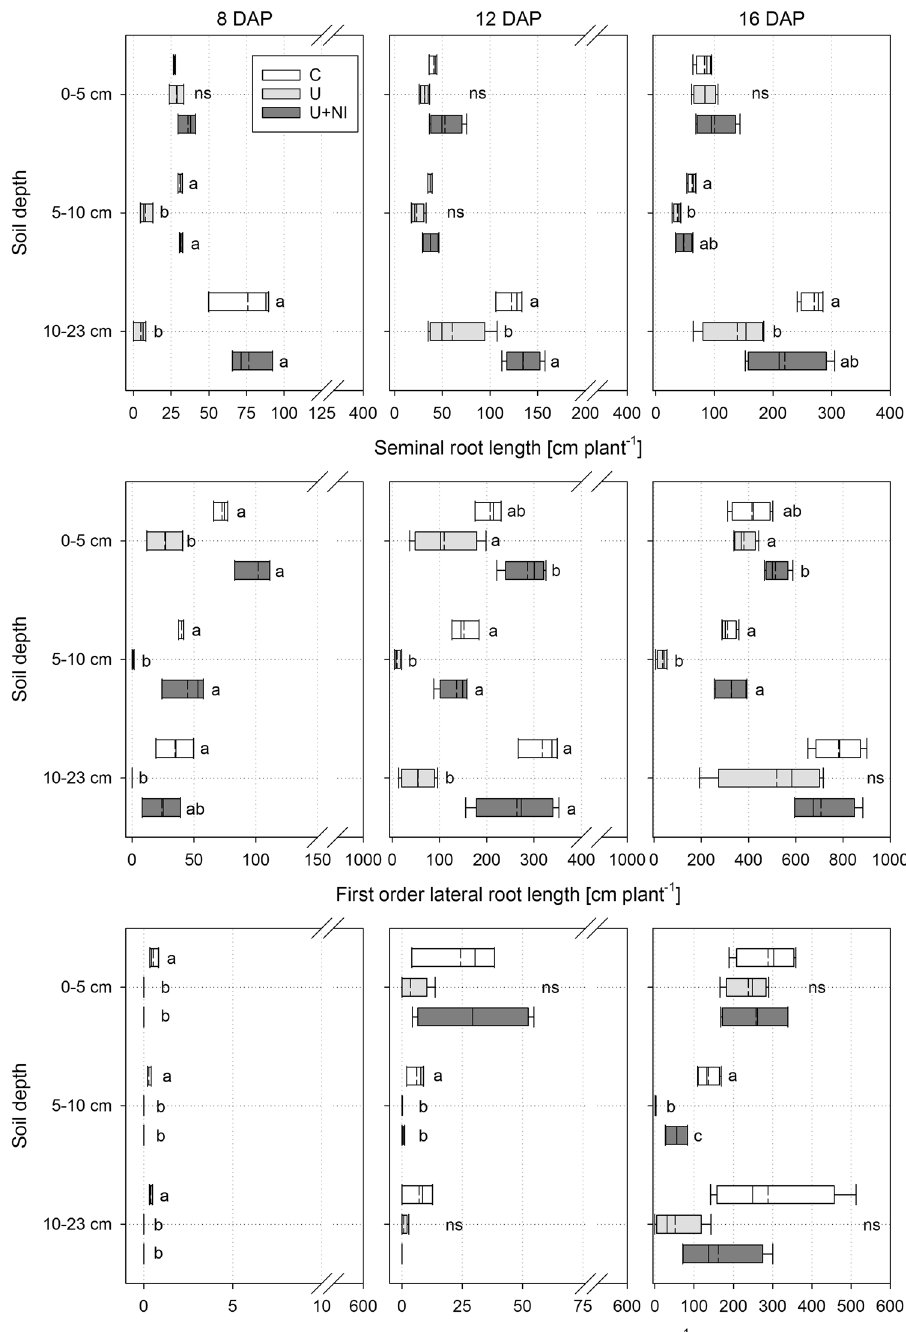
Figure 9. Root length of Hordeum vulgare plants, separated for three depths and root orders for each sampling point for the treatments control (“C”), urea (“U”) and urea with nitrification inhibitor (“U+NI”). Top layer (0–5 cm) is above fertiliser zone, bottom layer (10–23 cm) is below fertiliser zone. Top row = seminal roots, middle row = first order laterals, bottom row = second order laterals. Statistical comparison of root length is performed per layer between treatments. Significant differences ( p < 0.05) are indicated by different letters; ns = no significant difference for p < 0.05; dashed lines in the boxplots represent mean values while solid lines represent the